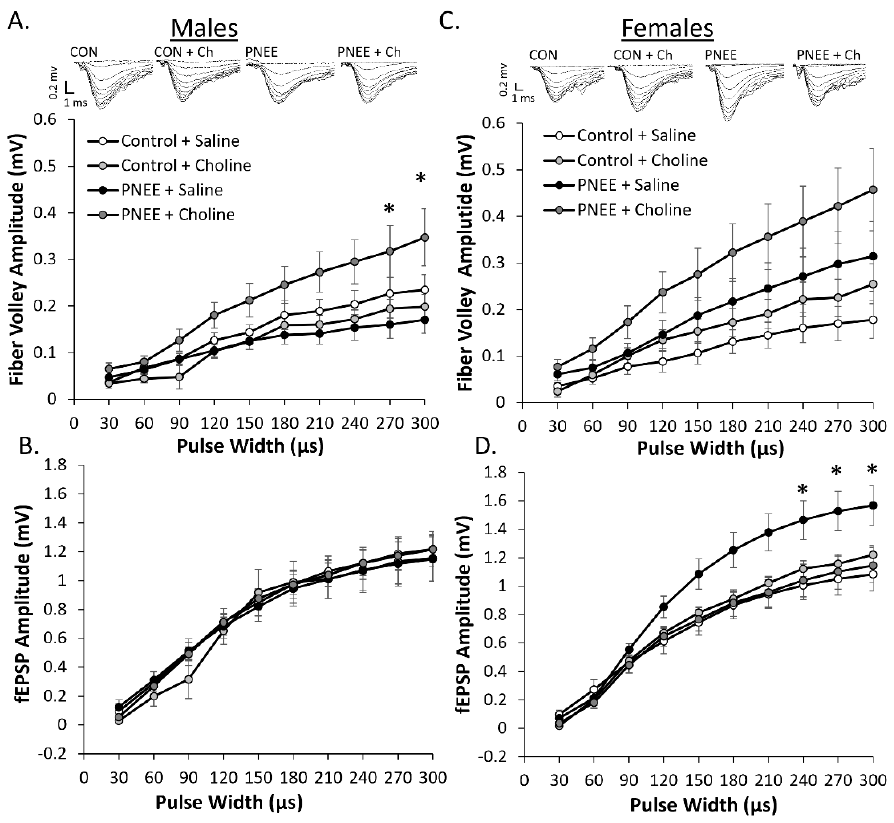
Figure 3. PNEE alters the stimulus response curve for field potentials in females. The average change in fiber volley amplitude with increasing pulse width for ( A ) male and ( B ) female offspring. The average change in fEPSP amplitude with increasing pulse width for ( C ) male and ( D ) female offspring. Control + saline = white, control + choline = light grey, PNEE + saline = black, and PNEE + choline = dark grey. Representative traces are above each graph. Error bars are ± SEM. * represents p < 0.05.